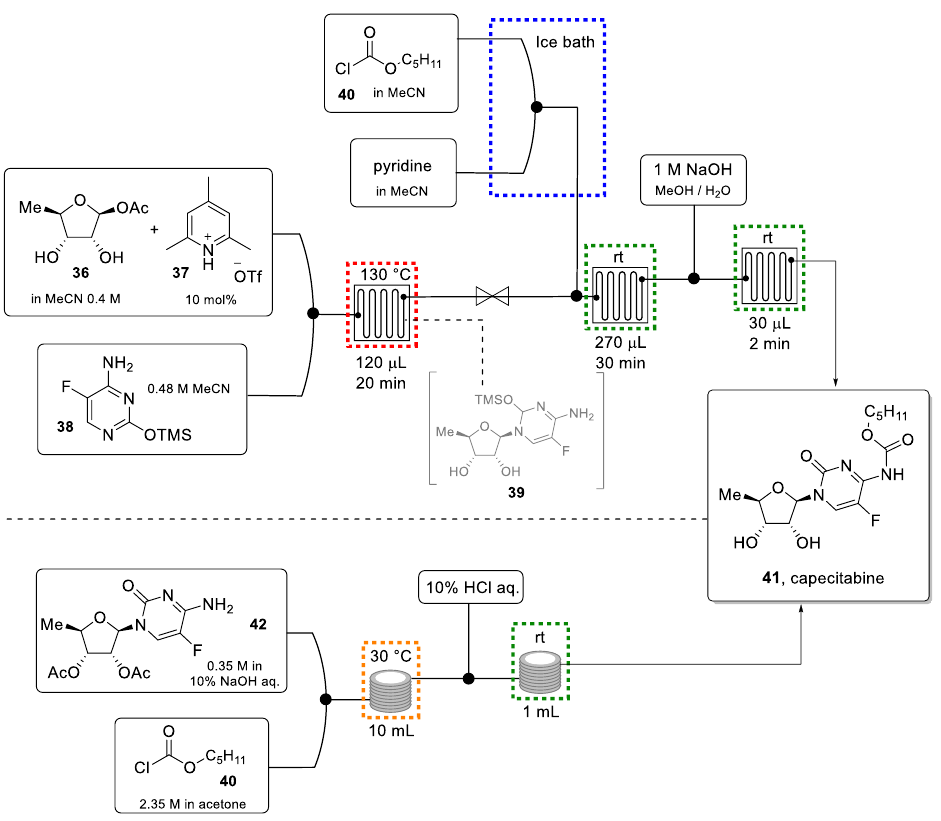
Scheme 8. Continuous flow synthesis of capecitabine reported by Jamison ( top ). continuous flow synthesis of the same drug reported by De M. Miranda ( bottom ).